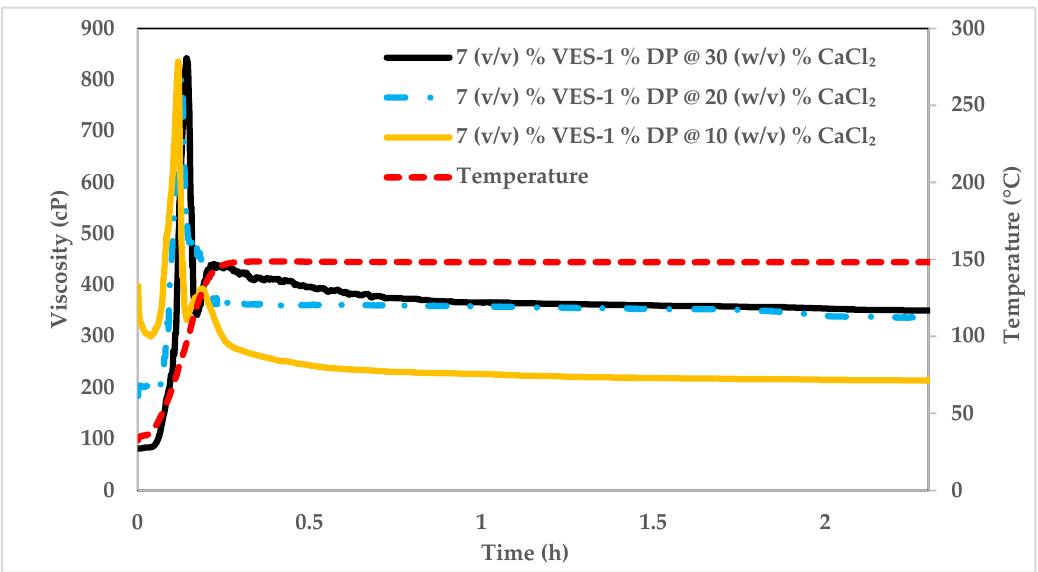
Figure 12. Viscosity profile of fluid with 7% ( v/v ) VES, 1% DP polymer only and 10%–30% ( w/v ) CaCl 2 in sea water solution. Measurement done at constant shear rate of 100 1/s.